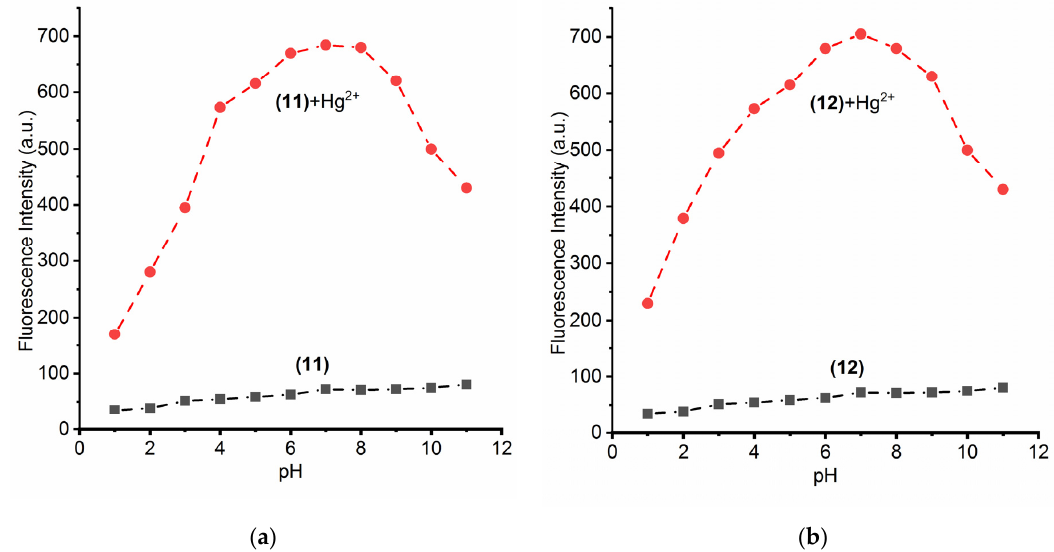
Figure 7. Effect of pH on nano-composites ( a ) → (11) and [(11)+Hg 2+ ] ; ( b ) → nano-composites (12) and its complex [(12)+Hg 2+ ] .